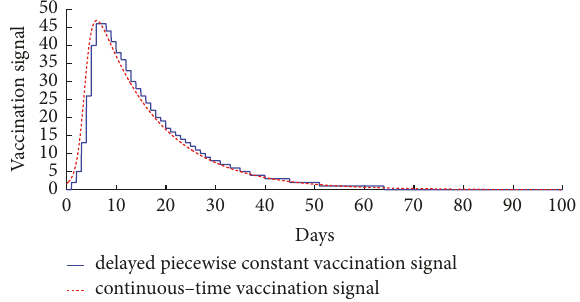
Figure 20: Evolution of the vaccination signals: (i) a delayed piecewise constant signal taking integer values and (ii) continuous- time